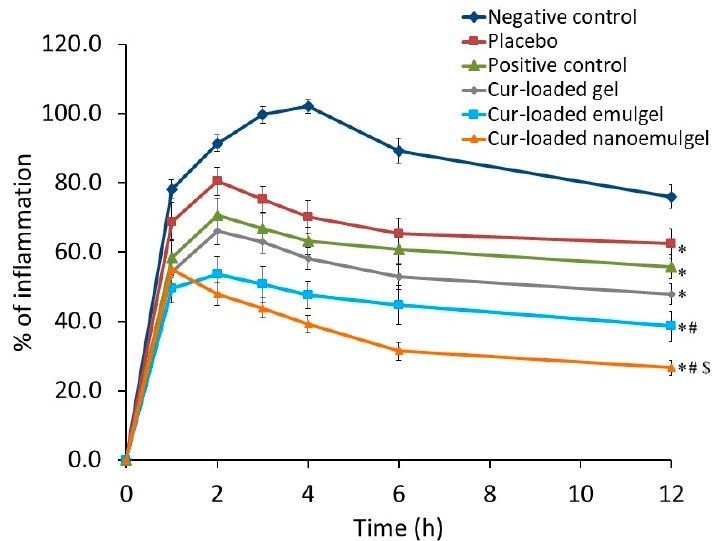
Figure 8. Effects of Cur-loaded formulations on carrageenan-induced paw edema in rats. Results are expressed as mean with the bar showing SD (n = 5). * p < 0.05 compared to negative control treated group. # p < 0.05 compared to Cur-loaded gel treated group. $ p < 0.05 compared to Cur-loaded emulgel treated group.